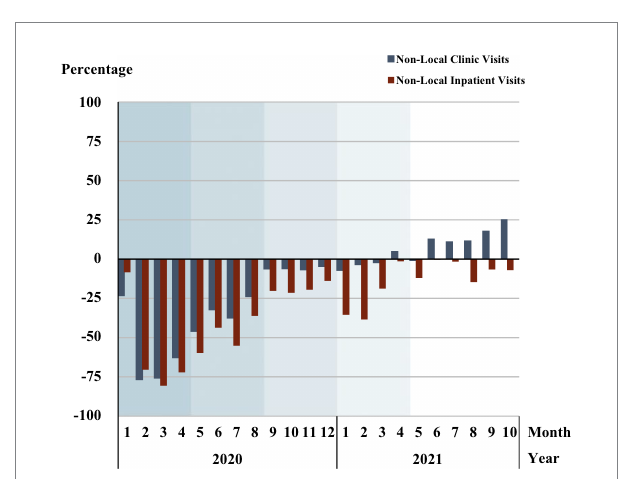
FIGURE 7 Percentage change in non-local patient visits in high-level hospitals. Each shadow area denotes COVID-19 phase 1 to phase